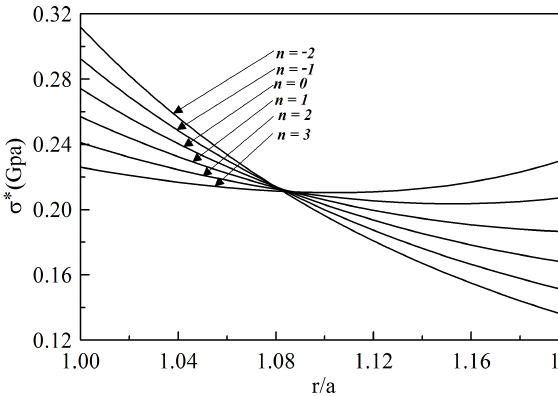
Figure 32: Radially distributed displacement